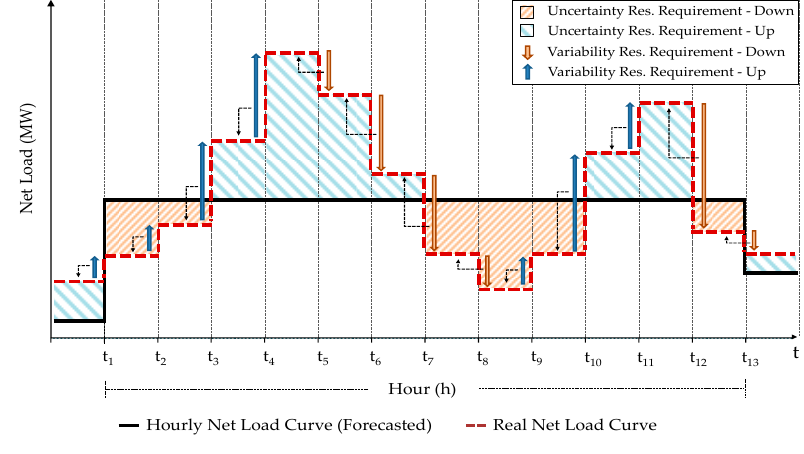
Figure 1. Definition of uncertainty and variability reserves.